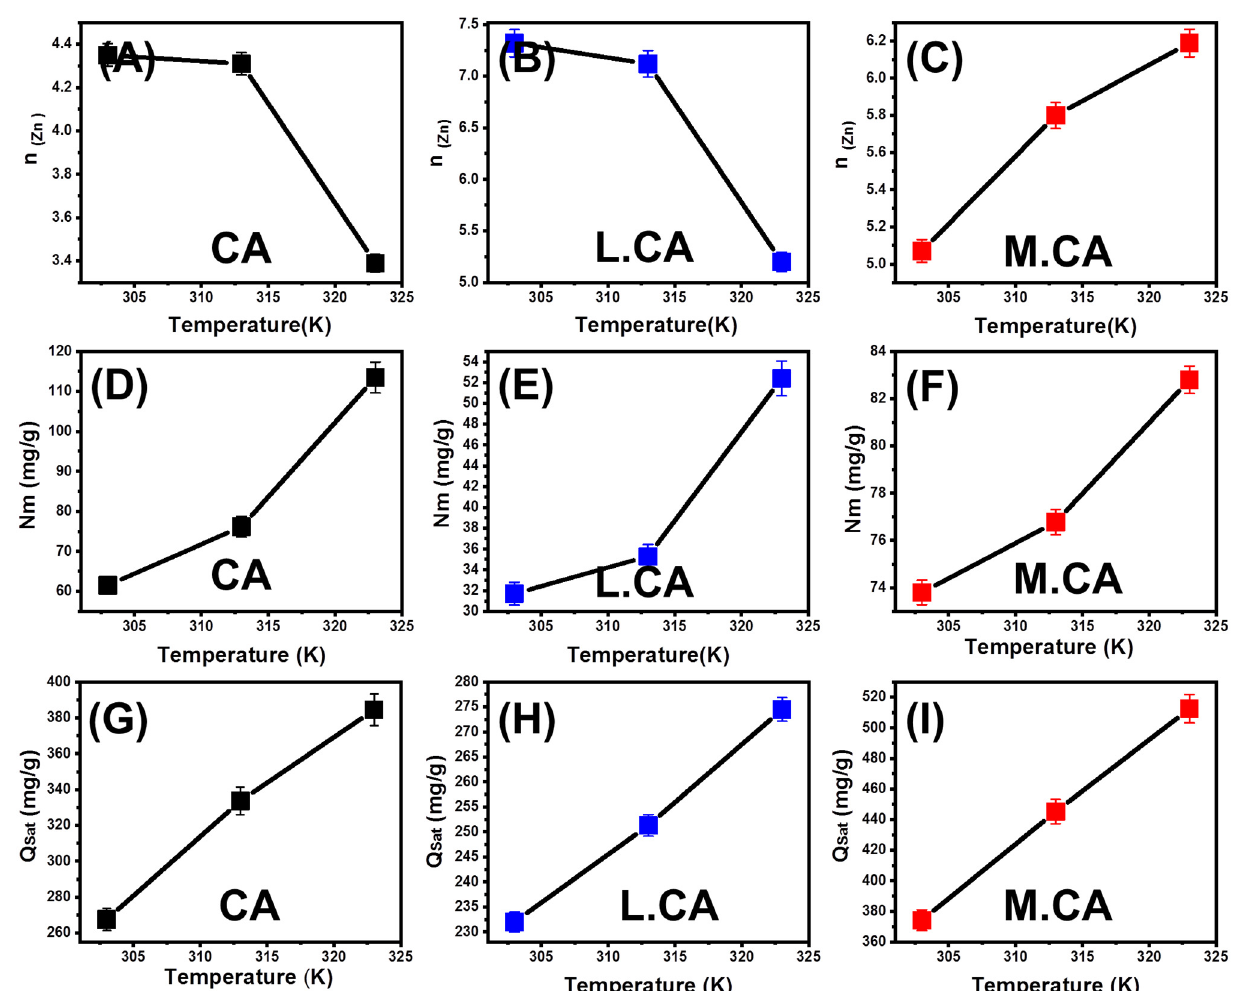
Figure 6. The change in the number of adsorbed Zn (II) ions per active site with temperature ( A – C ), the change in occupied active sites density of the calcite phases with temperature ( D – F ), and the change in the saturation retention capacities of the three calcite phases with temperature ( G – I ).